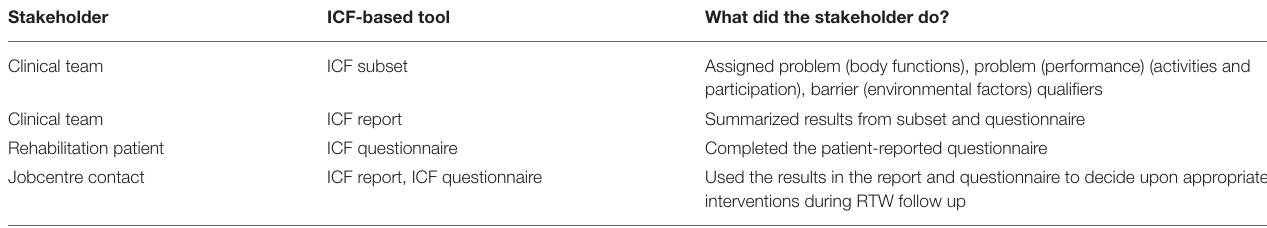
TABLE 1 | Overview of stakeholder involvement.